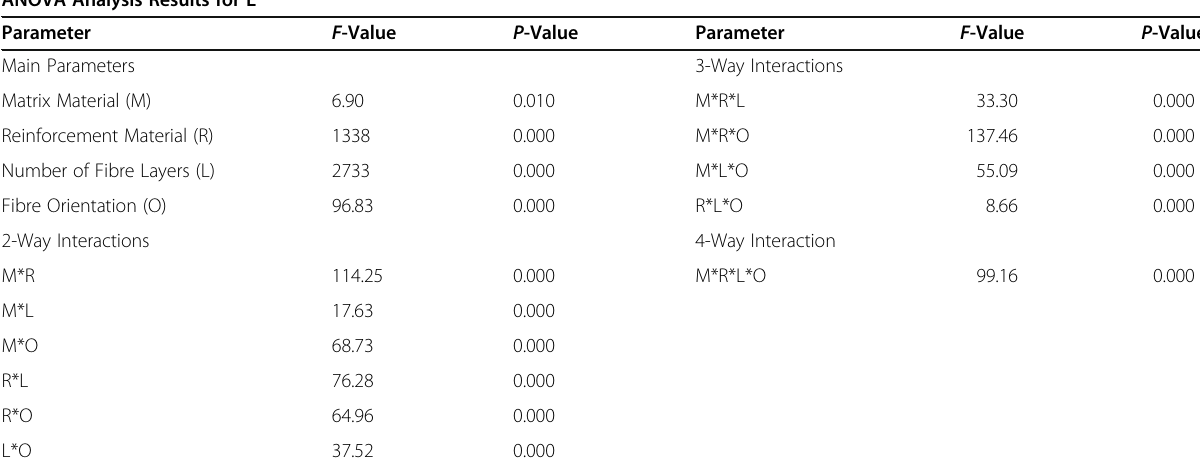
Table 5 ANOVA Results for Main Parameters and All Interactions for E ANOVA Analysis Results for E